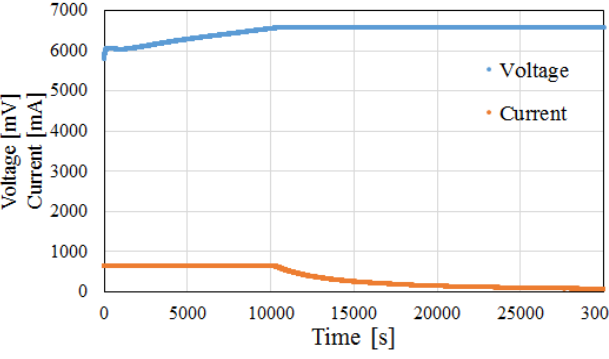
Figure 10. Characteristic of Pb battery during CCCV charging mode.